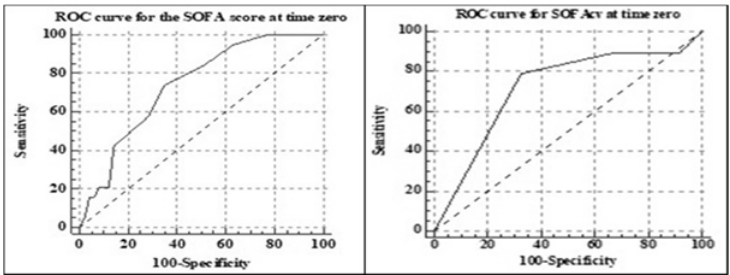
Figure 1. Receiver operating characteristic (ROC) curve analysis for Sequential organ failure assessment (SOFA) and cardiovascular SOFA at time zero.